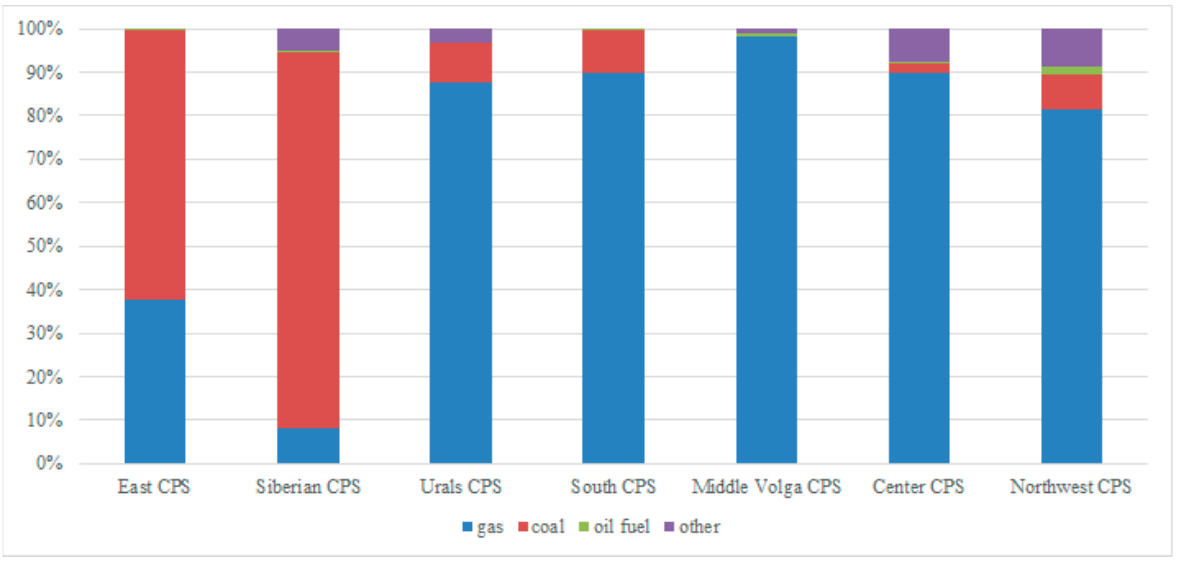
Figure 4. The structure of fuel consumption of TPPs in the CPSs of Russia (Source: Scheme and program for the development of the Unified Energy System of Russia for 2021–2027).